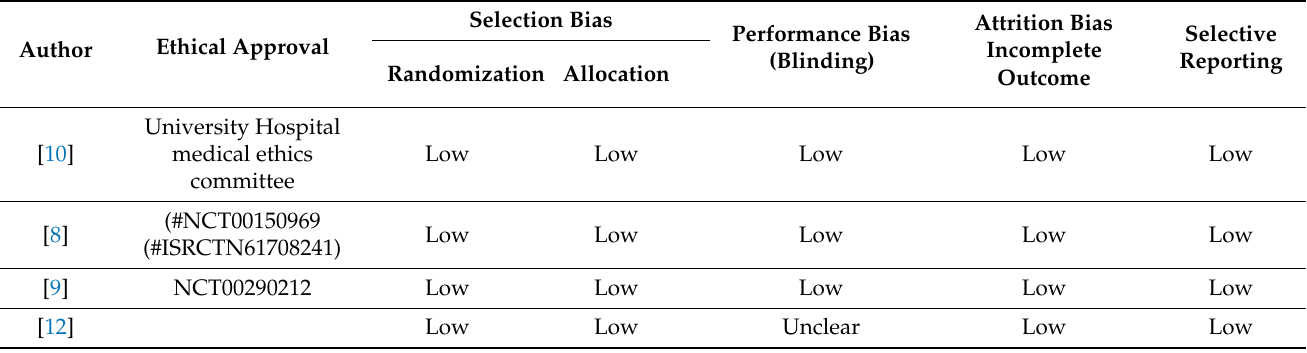
Table 1. Tabular representation of risk of bias assessment of included